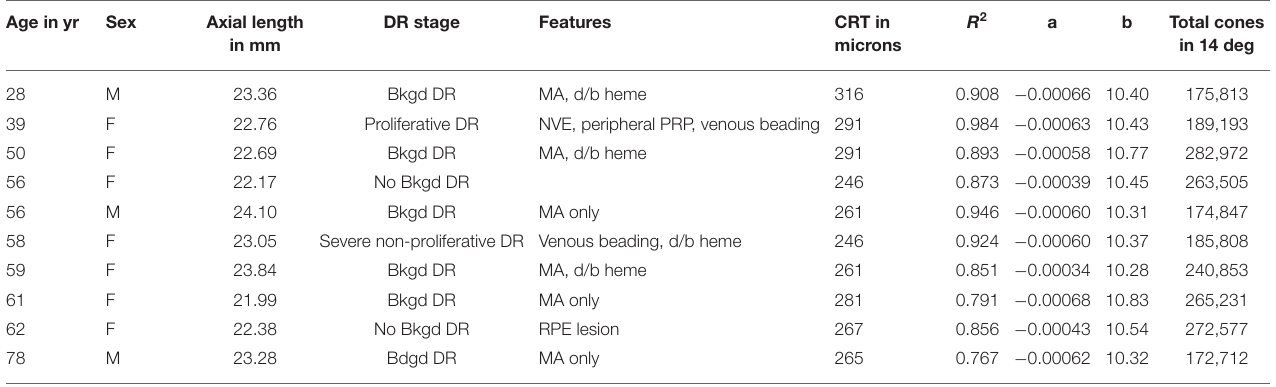
TABLE 1 | Age, sex, clinical characteristics, and sample results for the diabetic